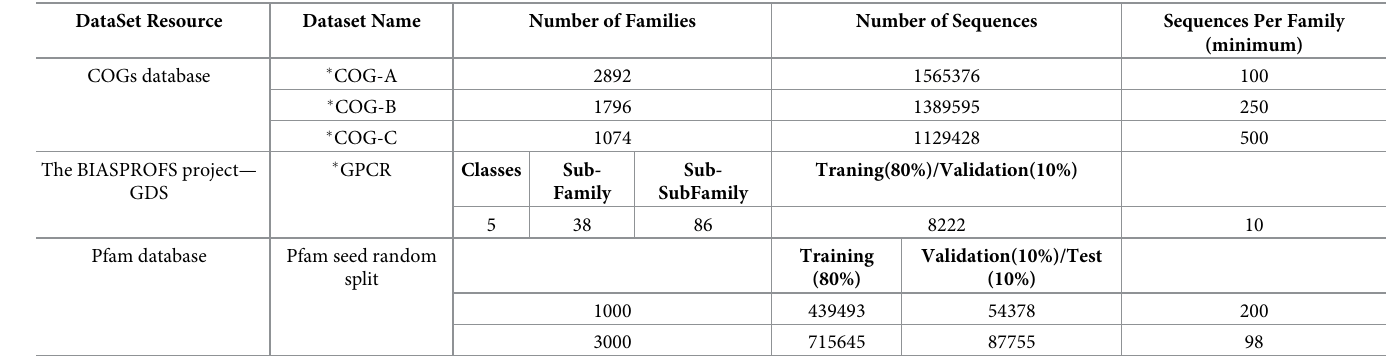
Table 1. Details of